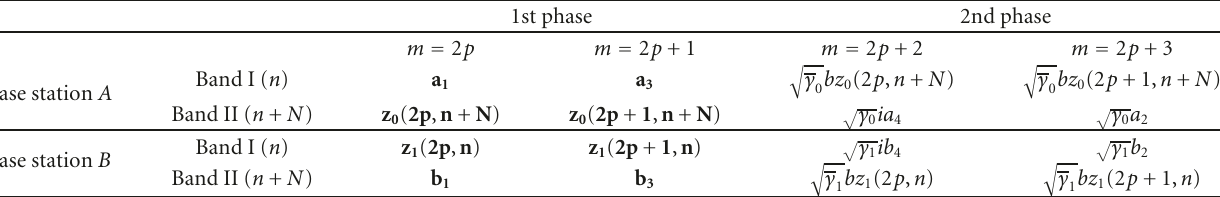
Table 2: Proposed CFR protocol based on the distributed Golden